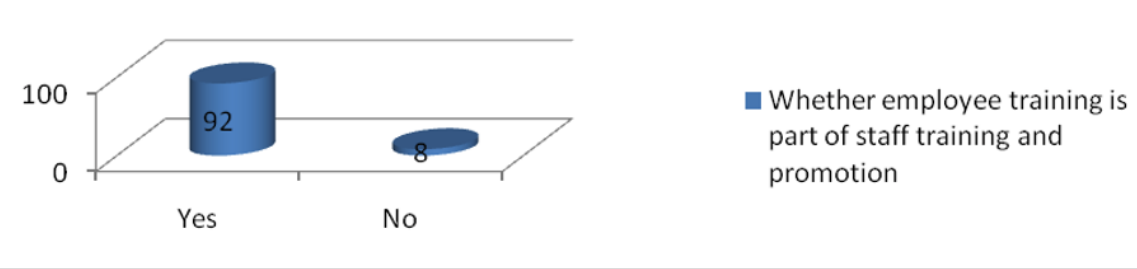
Figure 5: Employee training is part of staff training and promotion